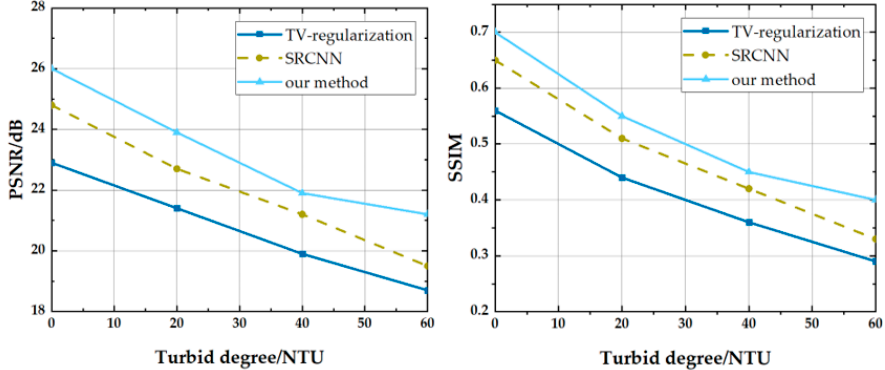
Figure 6. The index values for Bicubic and SRCNN at different magnifications. Table 1. Comparative analysis of different recovery methods with a sampling rate of 18.3% and scattering condition (the signal to noise ratio is 10 dB).